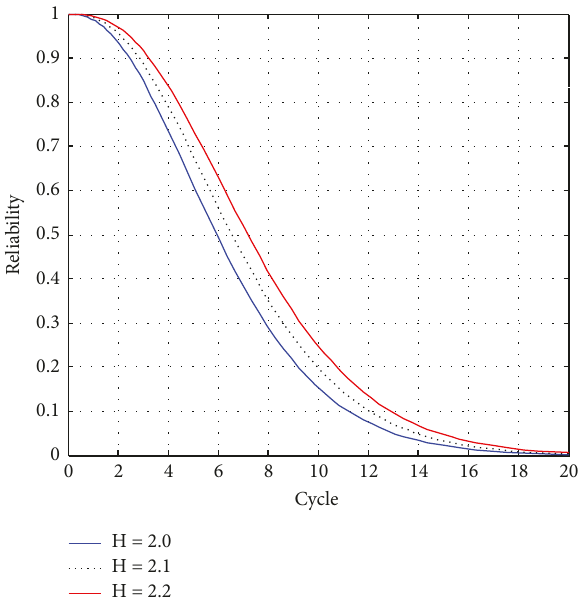
Figure 7: Sensitivity analysis of (P)